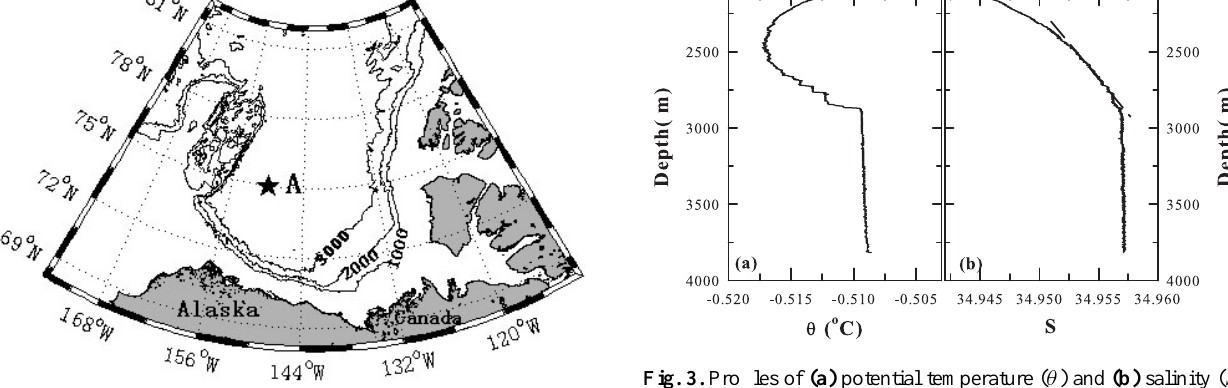
Fig. 2. Map of the Canada Basin in the Arctic Ocean. Isobaths are plotted using the ETOP data. The location of Mooring A is marked by a star.